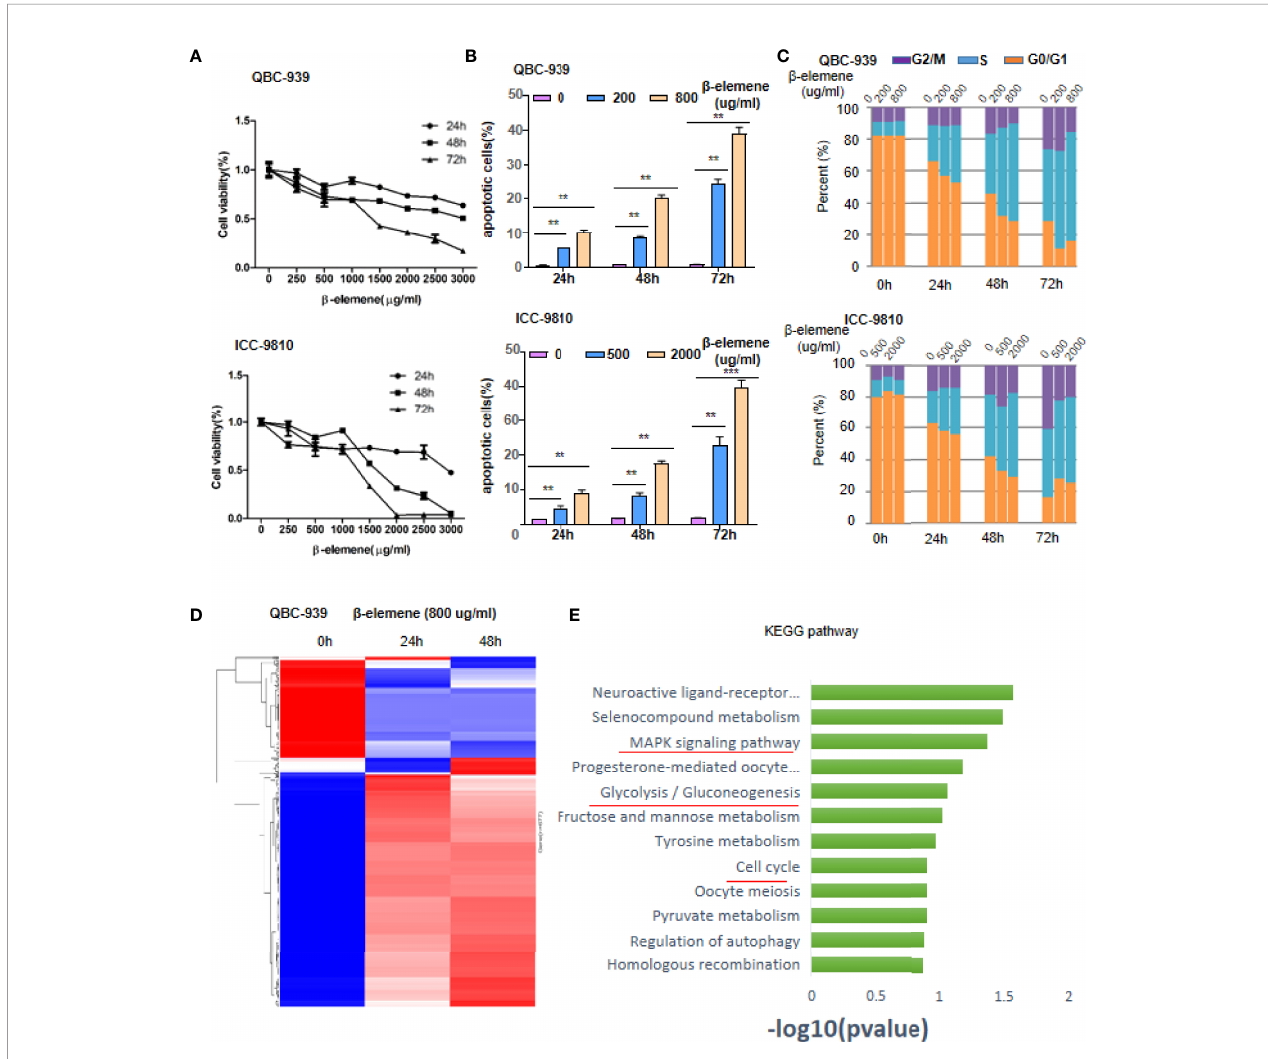
FIGURE 2 | b -Elemene induces apoptosis, cell cycle arrest of human cholangiocarcinoma (CCA) cells, and aberrant gene expression. (A) Cell viability of QBC-939 and ICC-9810 was measured by Trypan blue staining assay following b -elemene treatment at indicated concentrations and time points. (B) Apoptotic QBC-939 or ICC-9810 cells were tested by propidium iodide (PI)/annexin V double staining kit following b -elemene treatment at indicated concentrations and time points. ** p < 0.01; *** p < 0.001. (C) Cell cycle analysis. QBC-939 or ICC-9810 cells were administered with indicated concentrations and time points of b -elemene treatment. Then, cells were collected for PI staining and fl uorescence-activated cell sorting (FACS) analysis. (D, E) QBC-939 cells were treated with b -elemene (500 m g/ml) for 24 or 48 h and subjected to cDNA array analysis, and differentially expressed genes (fold change >1.5 or <0.67, p < 0.05) are shown in panel (D) Signi fi cant Kyoto Encyclopedia of Genes and Genomes (KEGG) pathway retrieved by clusters of genes involved in the intersection of two time points (E)